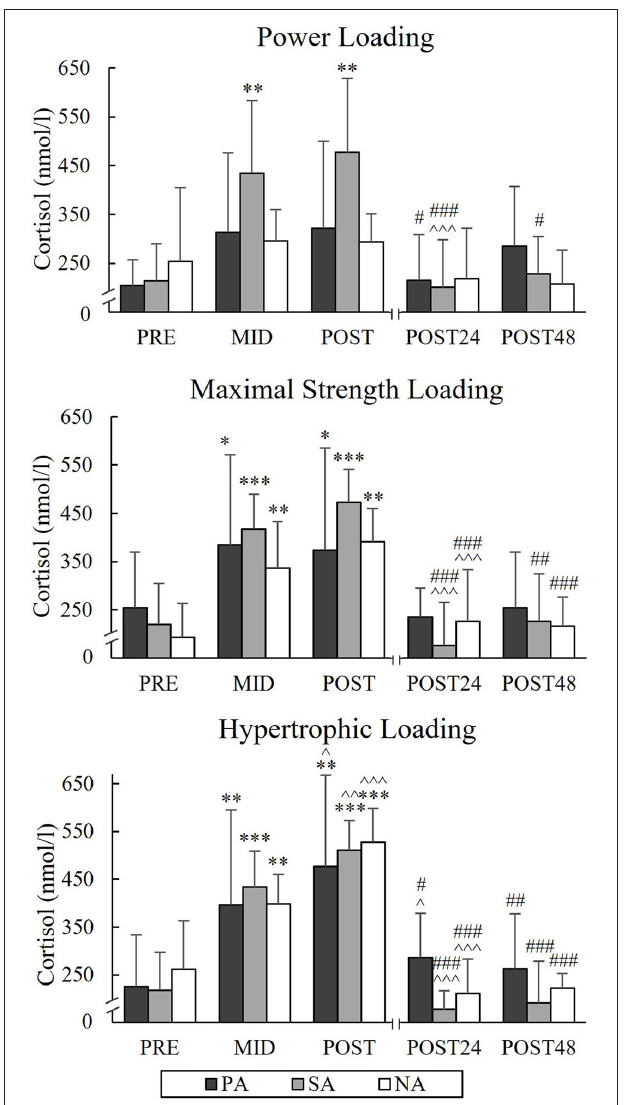
FIGURE 10 | Serum cortisol concentrations of Pre, Mid, Post, Post24, and Post48 during three resistance exercise loadings in power (PA), strength (SA), and non-athletes (NA). * p < 0.05, ** p < 0.01, *** p < 0.001 refer to within-group significances compared to Pre. ∧ p < 0.05, ∧∧ p < 0.01, ∧∧∧ p < 0.001 refer to within-group significances compared to the previous time point. # p < 0.05, ## p < 0.01, ### p < 0.001 refer to within-group significances compared to Post during recovery.